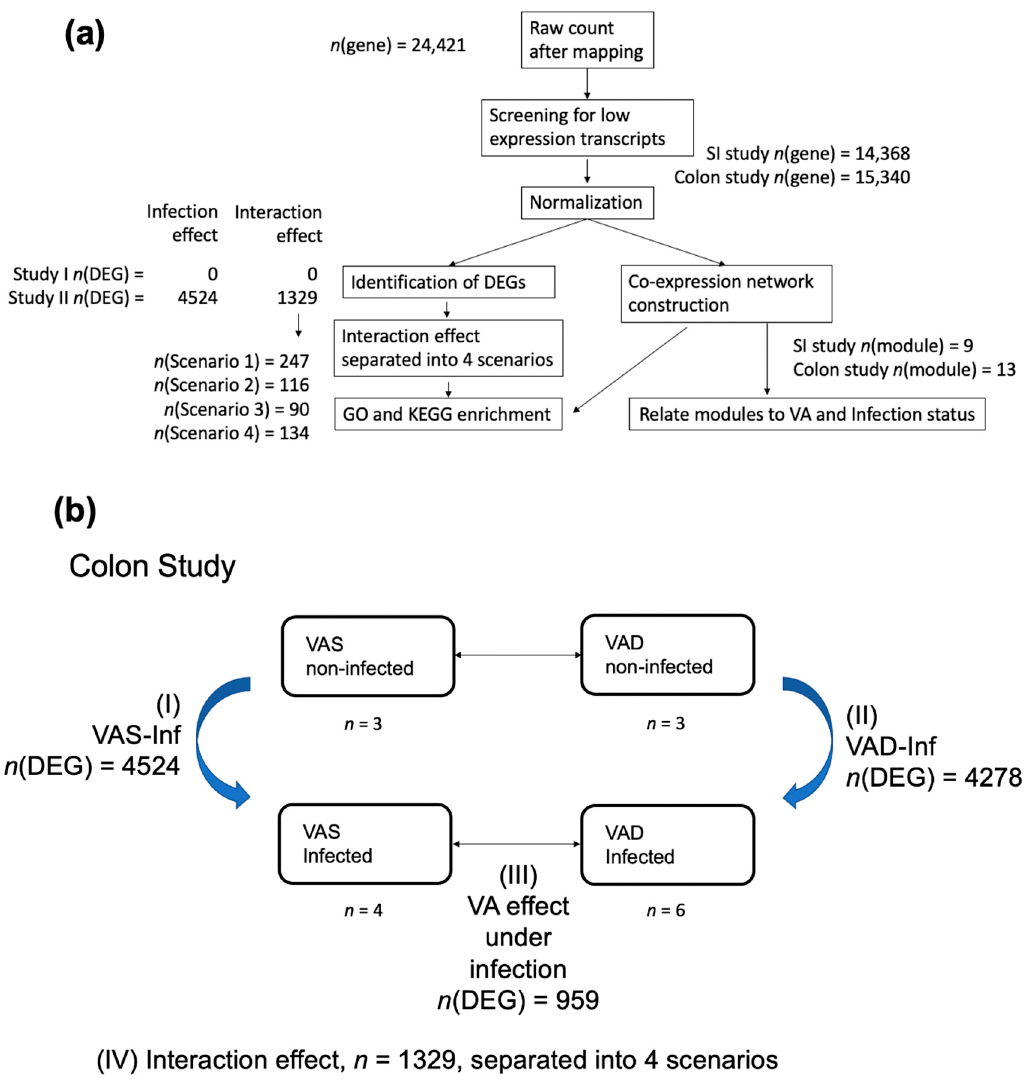
Figure 1. Overview: bioinformatics analyses results. ( a ) Initial mapping identified 24,421 genes. After the filtering of low-expression genes, 15,340 genes in the colon and 14,368 genes in the SI were retained, respectively. Among the 15,340 colon genes expressed in the colon, 4524 DEGs corresponding to the VAS-Inf effect and 1329 DEGs corresponding to the interaction effect were identified. However, no DEGs corresponding to the VAS-Inf or the interaction effect were found in the SI dataset. Due to the complexity of the interaction effect, different scenarios were isolated based on gene expression patterns, creating sublists of DEGs of the interaction effect, among which four of the scenarios were used in the enrichment analysis and visualization. Thirteen co-expression modules were identified in the colon via the WGCNA; ( b ) n (DEG) was the number of DEGs in each of the comparisons (padj < 0.05 and |FoldChange| > 2). The number of DEGs corresponding to the VAS-Inf effect (list I), the VAD-Inf effect (list II), the VA effect under infection (list III), and the interaction effect (list IV) was 4524, 4278, 959, and 1329, respectively. For the full length of each gene list see the supplementary Excel file. Abbreviations : Infection effect under the VAS status (VAS-Inf), infection effect under the VAD status (VAD-Inf), differentially expressed gene (DEG), Gene Ontology (GO), weighted gene co-expression network analysis (WGCNA), Kyoto Encyclopedia of Genes and Genomes (KEGG), small intestine